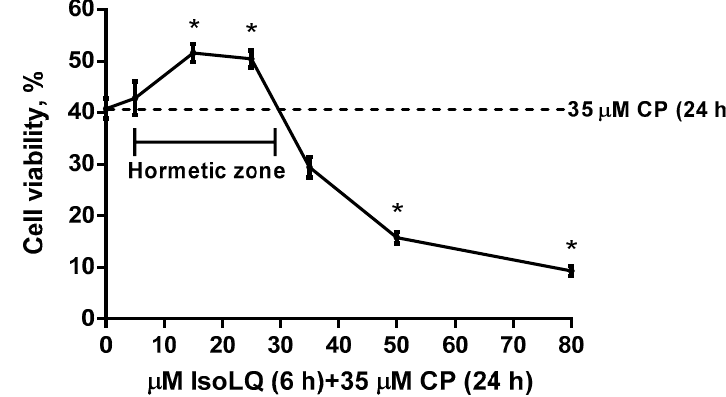
Figure 3. Hormetic dose-response curve of isoliquiritigenin (IsoLQ) in cisplatin (CP)-induced LLC-PK1 cell death. Data are mean ± SEM, n = 3. * p < 0.05 vs. CP 24 h.